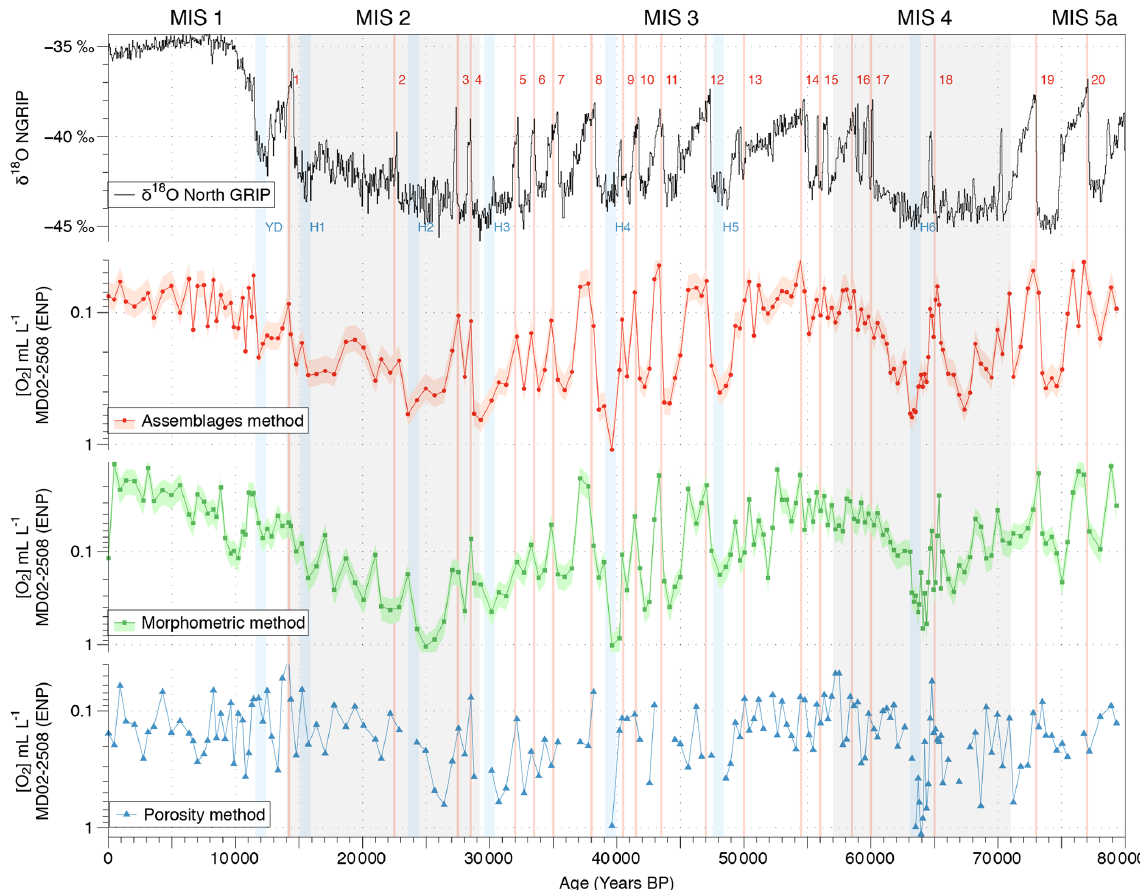
Figure 6. Comparison between the isotopic composition ( δ 18 O record) of the NGRIP ice core from Johnsen et al. (2001) and bottom water [O 2 ] variations estimated using the calibrated assemblage (red circles), the morphometry (green squares), and the porosity (blue triangles) methods. The pink and light green shades represent the 23% and 24% uncertainty in the assemblage and morphometry approaches,